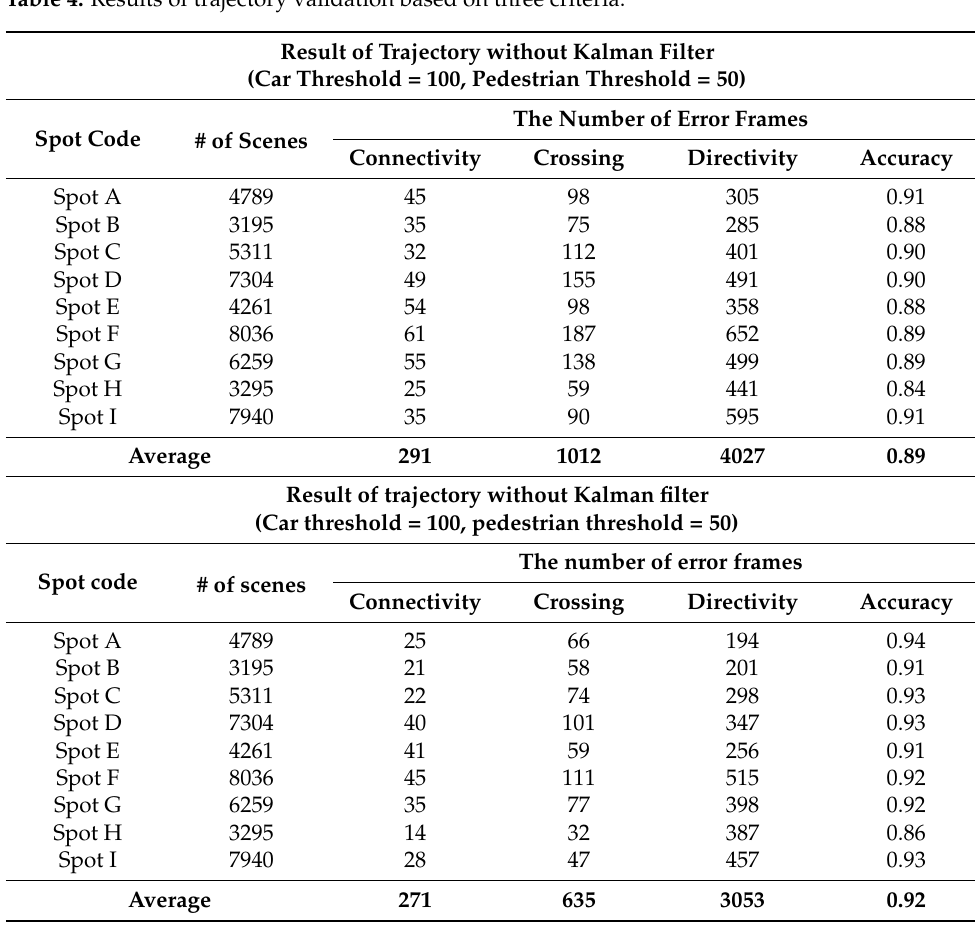
Table 4. Results of trajectory validation based on three criteria.